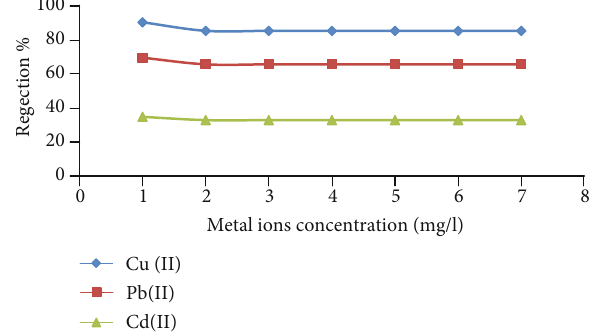
Figure 16: In fl uence of the WPE/PAMK-TFN membrane fi ltration cycles on heavy metal ions rejection. (pH7, p = 20bar